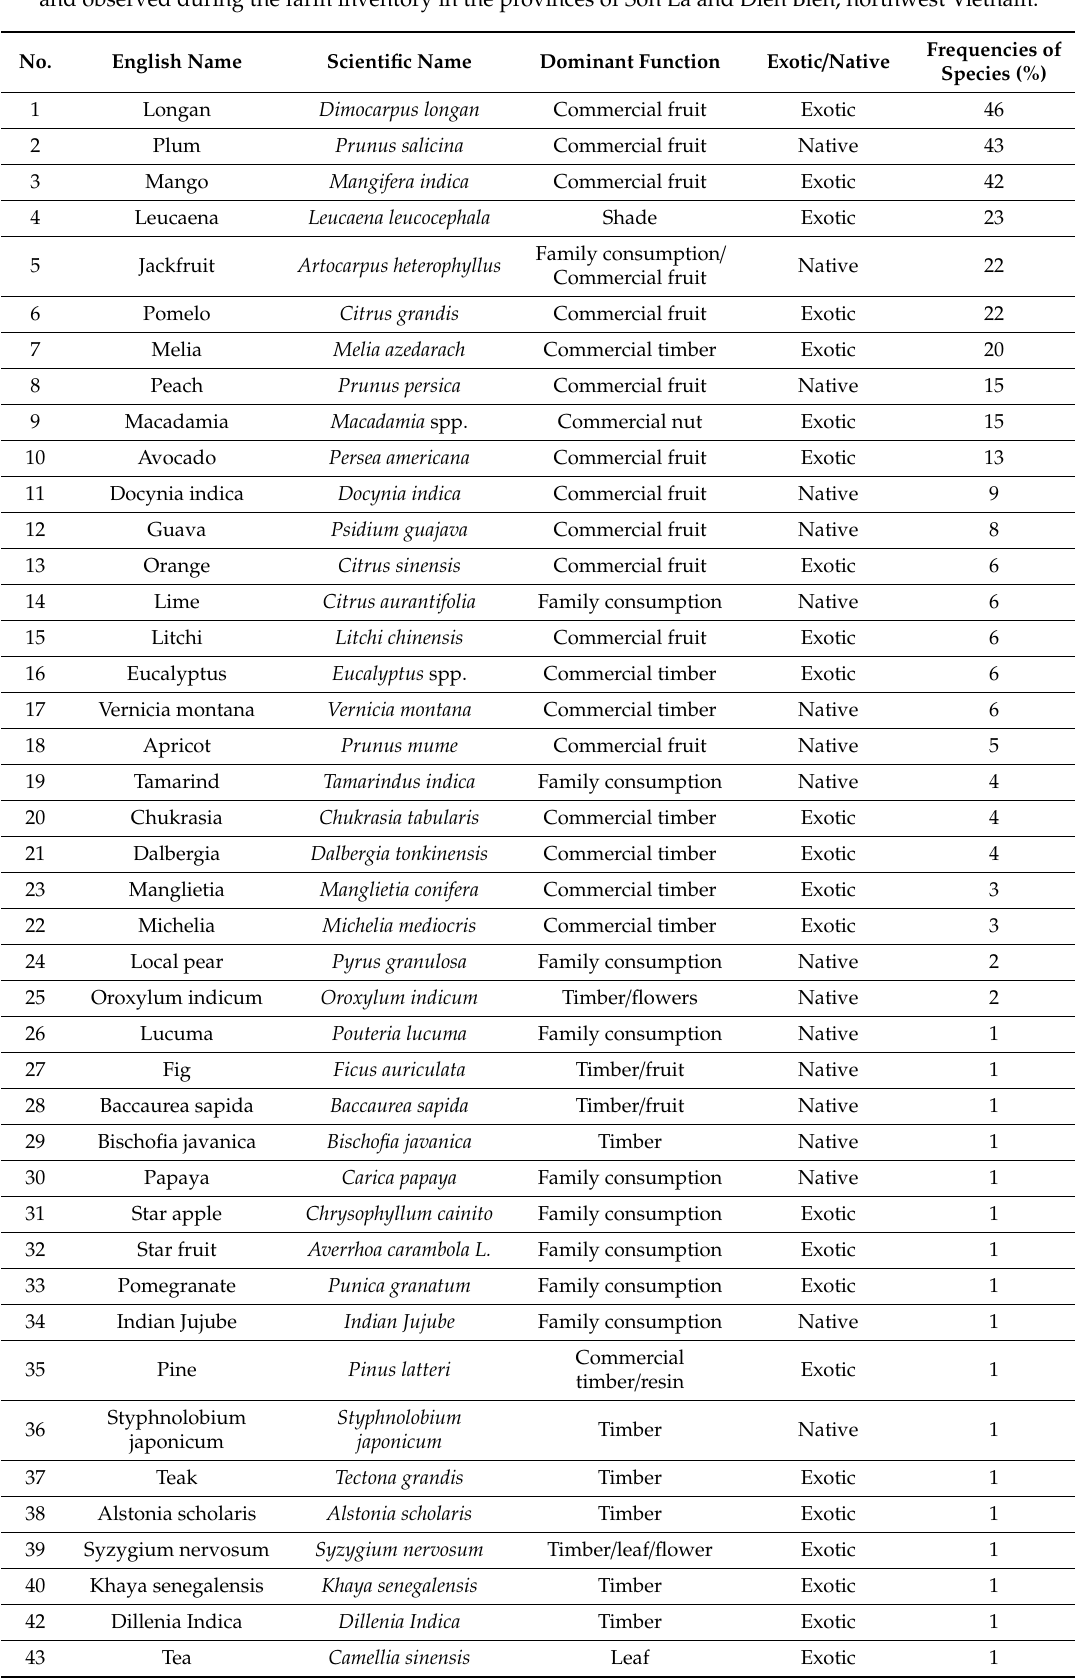
Table 2. Characterization of the tree species mentioned by farmers as growing on their co ff ee farms and observed during the farm inventory in the provinces of Son La and Dien Bien, northwest